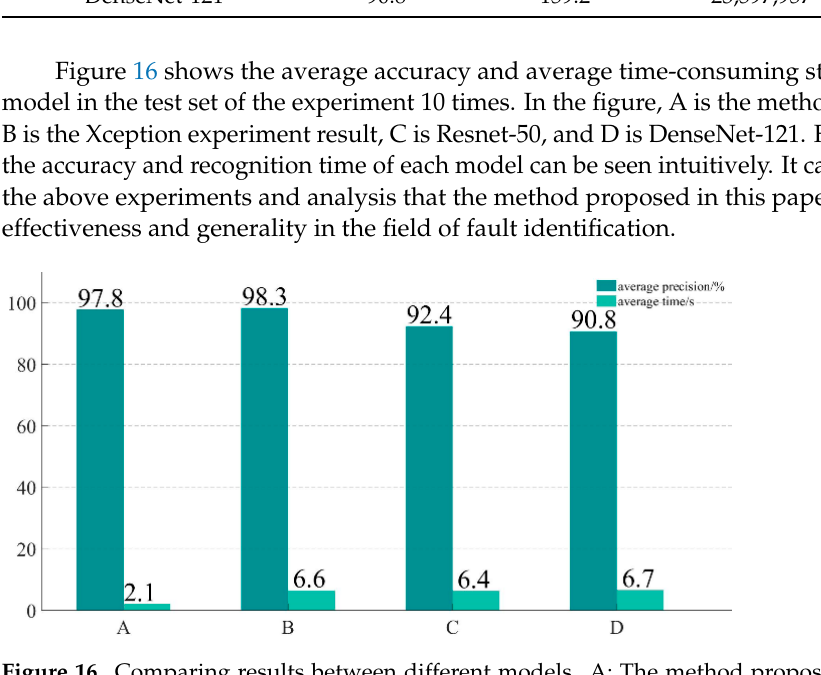
Table 9. Comparison between Different Methods.